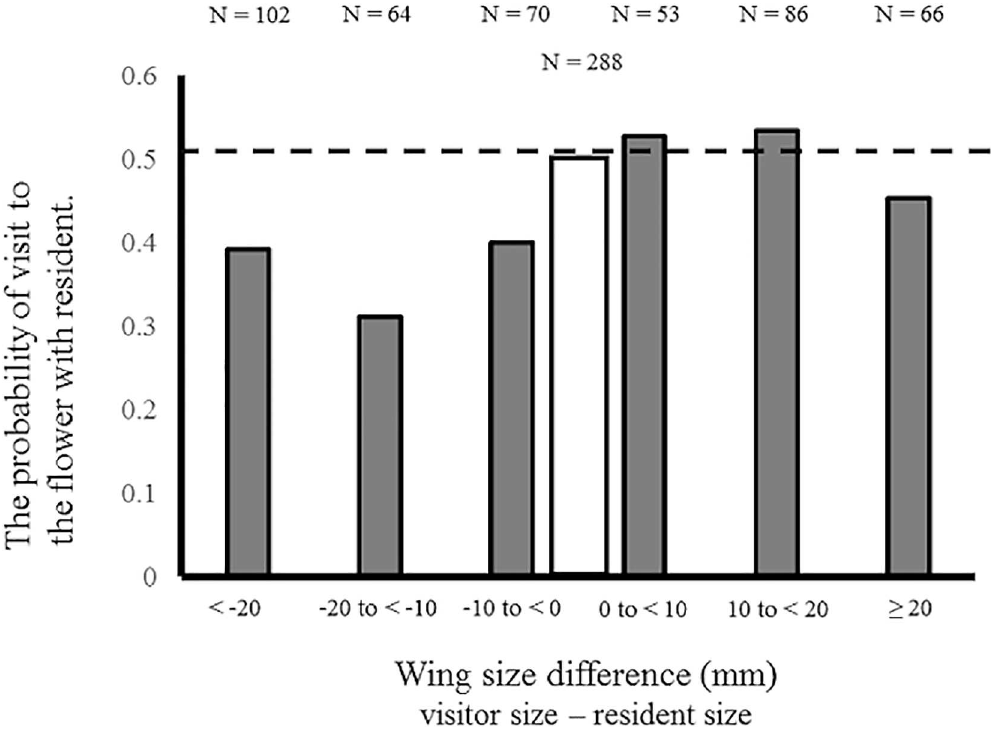
Fig 4. The probability of visit to an artificial flower occupied by a resident. Filled bar represents the average probabilityin each class of wing-sizedifferences betweenthe visitor and the resident butterfly species. Open bar representsthe probabilityof visit to the flower occupiedby a conspecific resident (wing size difference is zero).